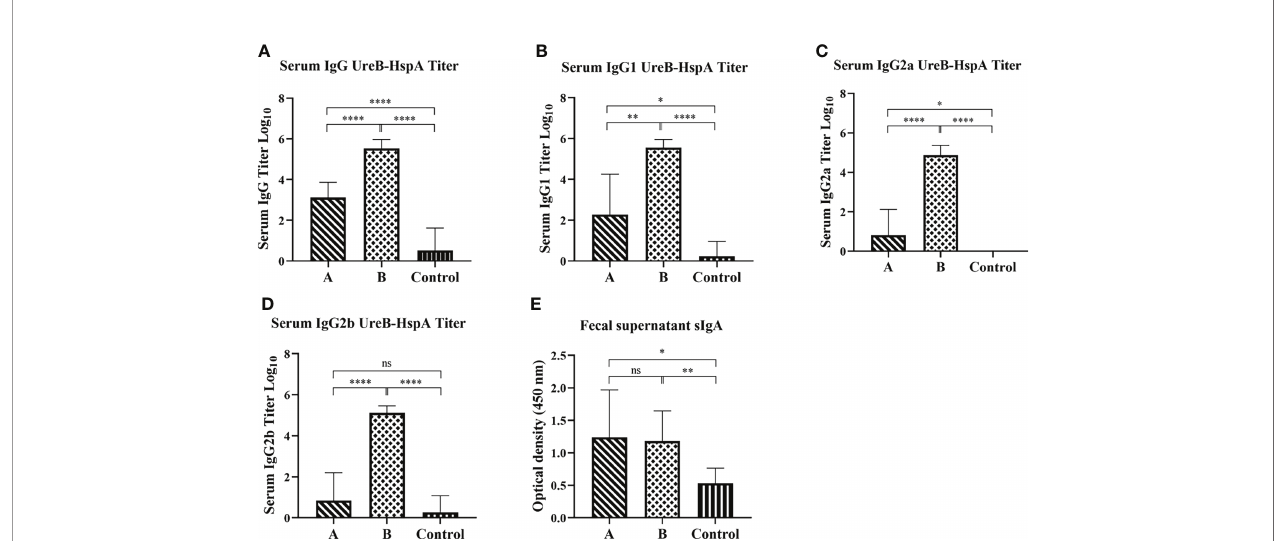
FIGURE 3 | Mucosal and humoral immune responses induced by immunization. Two weeks following the fi nal immunization, serum and feces of the mice were collected before the challenge and the antigen-speci fi c IgG (A) , IgG1 (B) , IgG2a (C) , IgG2b (D) , and sIgA (E) levels were measured by ELISA. The data were presented as mean ± SD, and differences between groups were tested using one-way ANOVA followed by Bonferroni ’ s multiple-pair comparison test. * p < 0.05, ** p < 0.01, **** p <